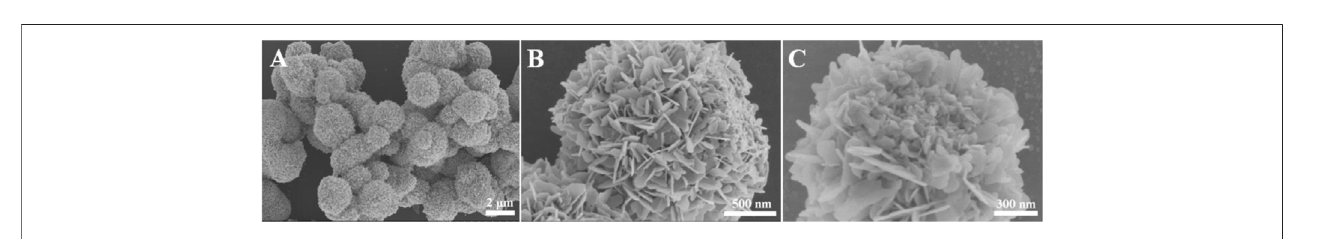
FIGURE 1 | SEM images of Bi 2 MoO 6 (A,B) and Bi 2 MoO 6 after reacting with L-Cys (C)